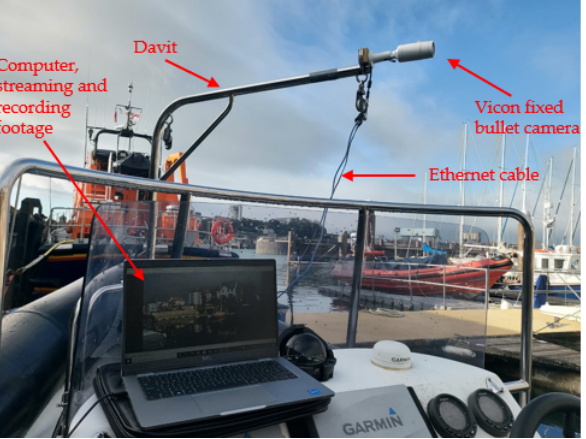
Figure 3. Camera setup on the Explorer whilst moored at Millbay marina. A Vicon fixed bullet camera is attached to a davit on the Explorer, faced at a 90-degree angle to the sea. The footage is streamed onto the computer using an Ethernet cable. Table 1. Weather conditions on days of filming including the minimum and maximum temperature, average wind speed and minimum and maximum rainfall at time of filming. Data used in this table is provided by the Western Channel Observatory [33], collected from the weather station located on Rame Head, Cornwall. The weather station location is shown in Figure